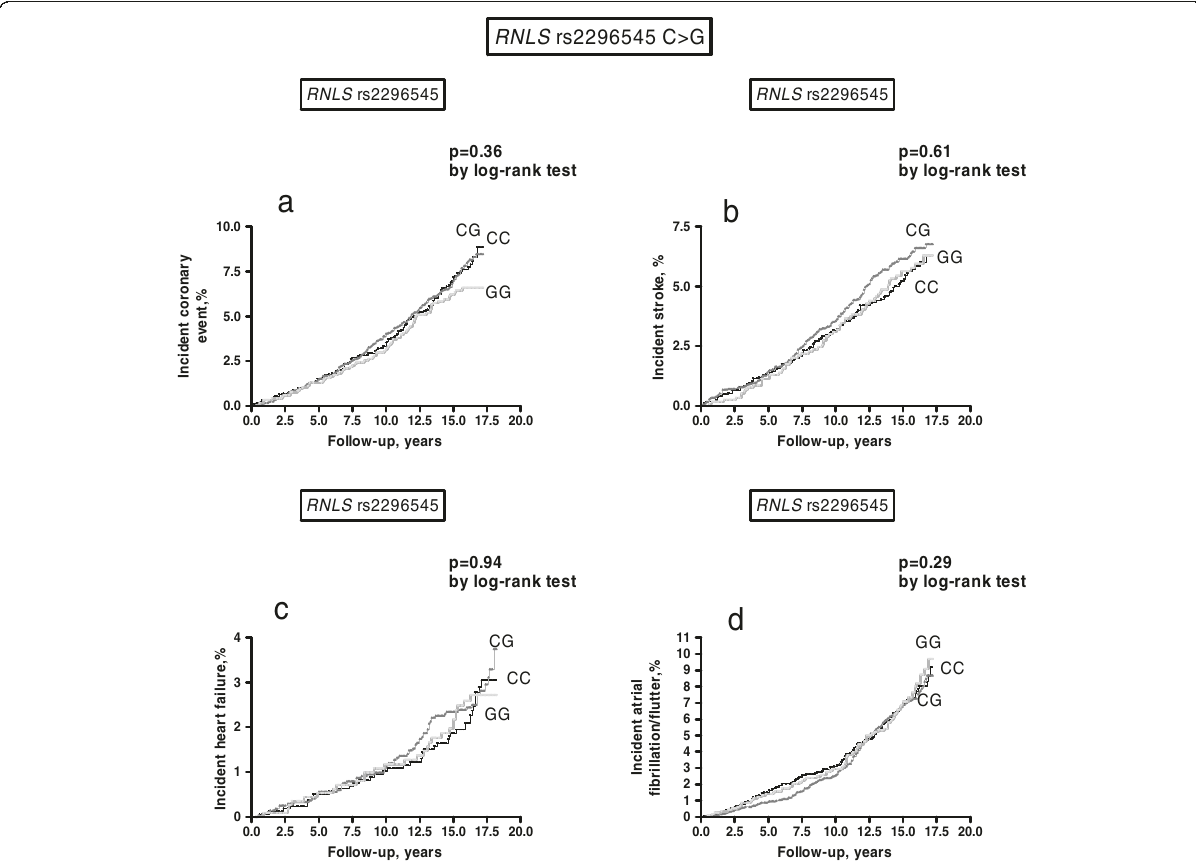
Figure 2 Incident coronary events (a), stroke (b), heart failure events (c), atrial fibrillation/flutter events (d), in carriers of different RNLS rs2296545 C > G